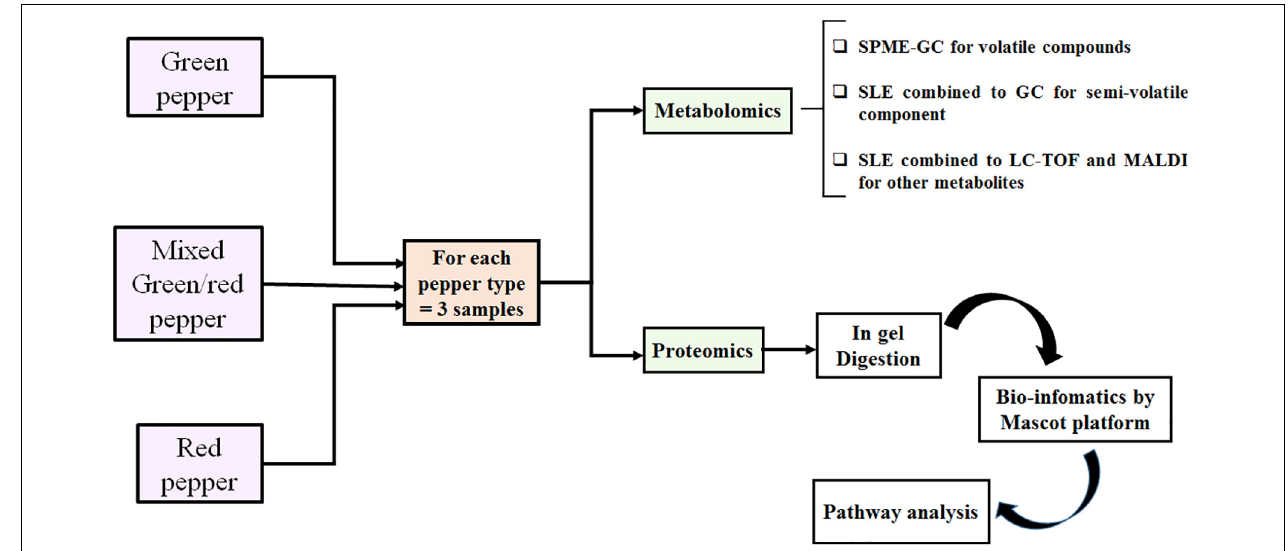
FIGURE 1 | Workflow of experimental strategy followed for metabolomics and proteomics analyses.